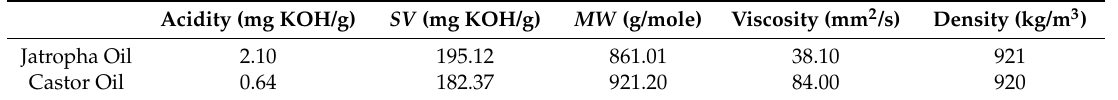
Table 2. Chemical and physical properties of the feedstock oils.